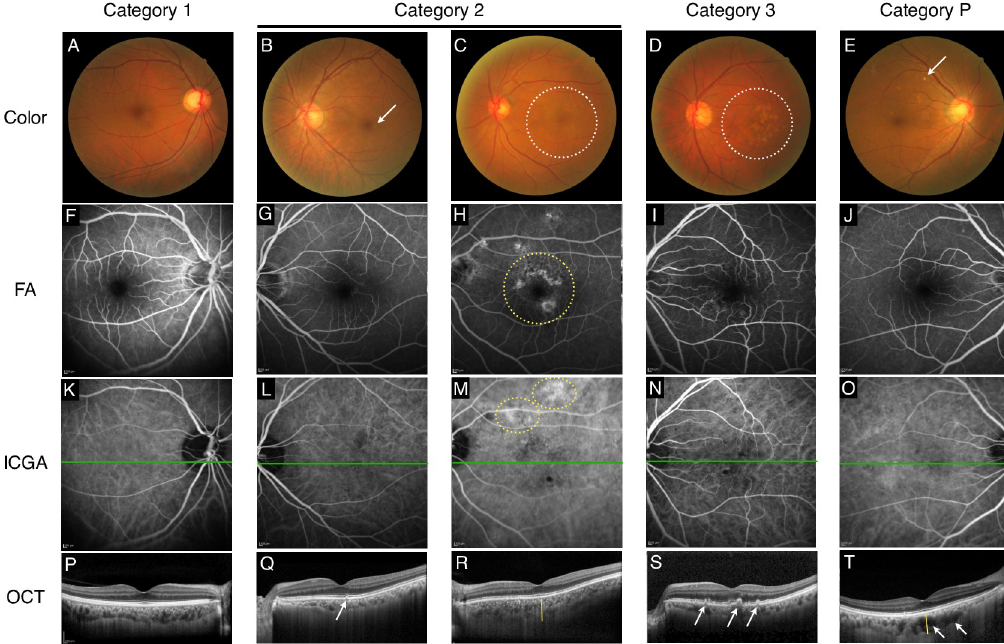
Fig 1. Classification of fellow eye’s conditions with multimodal imaging findings. Representative images of fundus photograph (A-E), FA (F-J), ICGA (K-O), and OCT (P-T) for each category. Representative images for Category 1 (A, F, K, and P) showed neither drusen > 63 μ m nor pigmentary abnormality. Representative images for Category 2 (B, G, L, and Q) accompanied by 63–125 μ m medium drusen (See an arrow in B). Note the drusen detectable by OCT as well (an arrow in Q). Representative images for Category 2 (C, H, M, and R), associated with pigmentary abnormality (See a circle in C). The RPE abnormality was revealed by the finding of window with FA (a yellow circle in H). Concurrent choroidal vascular hyperpermeability was detected by ICGA (yellow circles in M). Note that thick choroid presented (as indicated by a yellow line in R) and that sub-RPE deposits was not seen (R). Representative images for Category 3 (D, I, N, and S); soft drusen lager than 125 μ m accumulating on the macula (a circle in D). OCT detected dome-shaped elevations of RPE (arrows in S). Representative images for Category P (E, J, O, and T), presenting pachydrusen as an isolated large drusen outside the macular area (an arrow in E). Note that pigmentary abnormality or macular drusen was not observed. Dilated choroidal vessels (pachyvessels; arrows in T) and thick choroid (as illustrated by a yellow line in T) was observed. Horizontal green line (K, L, M, N, and O) represents where OCT scans